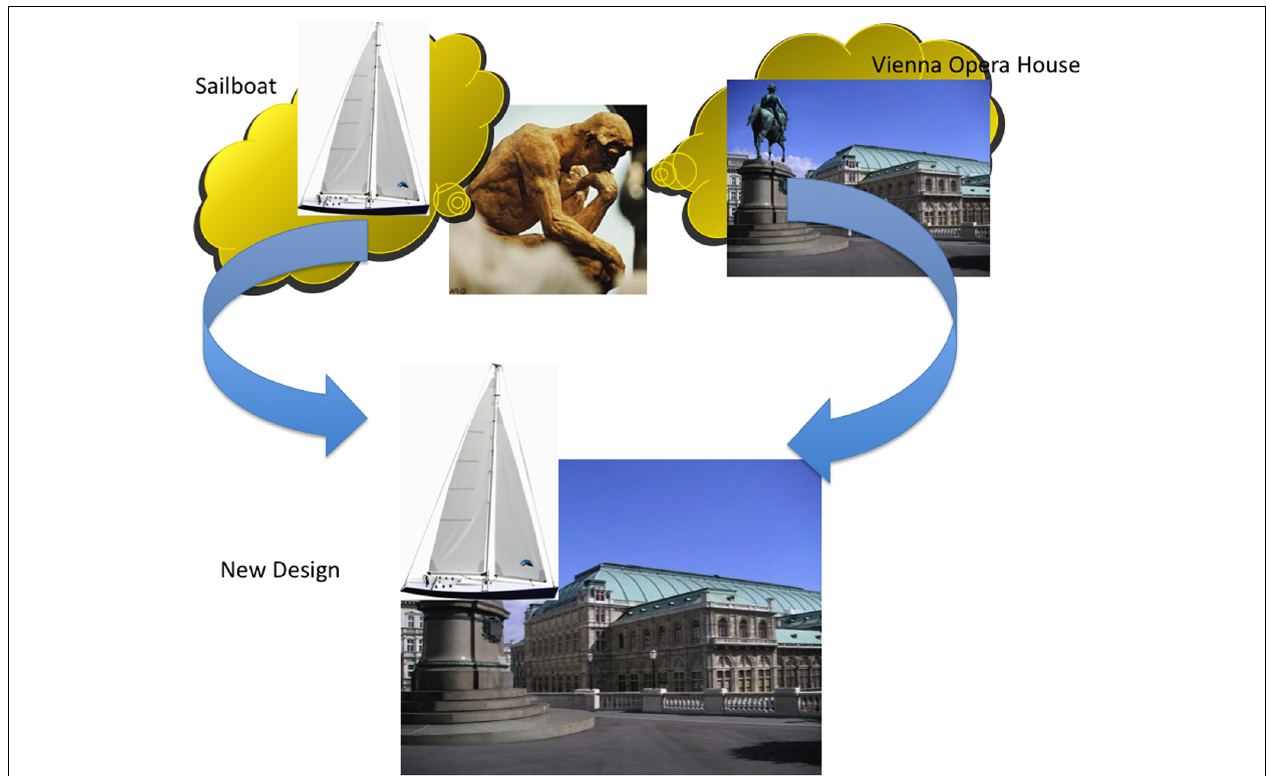
FIGURE 2 |The select-and-combine model of creativity. The above selection and combination are consistent with the select-and-combine model, and serve to highlight its inadequacy.